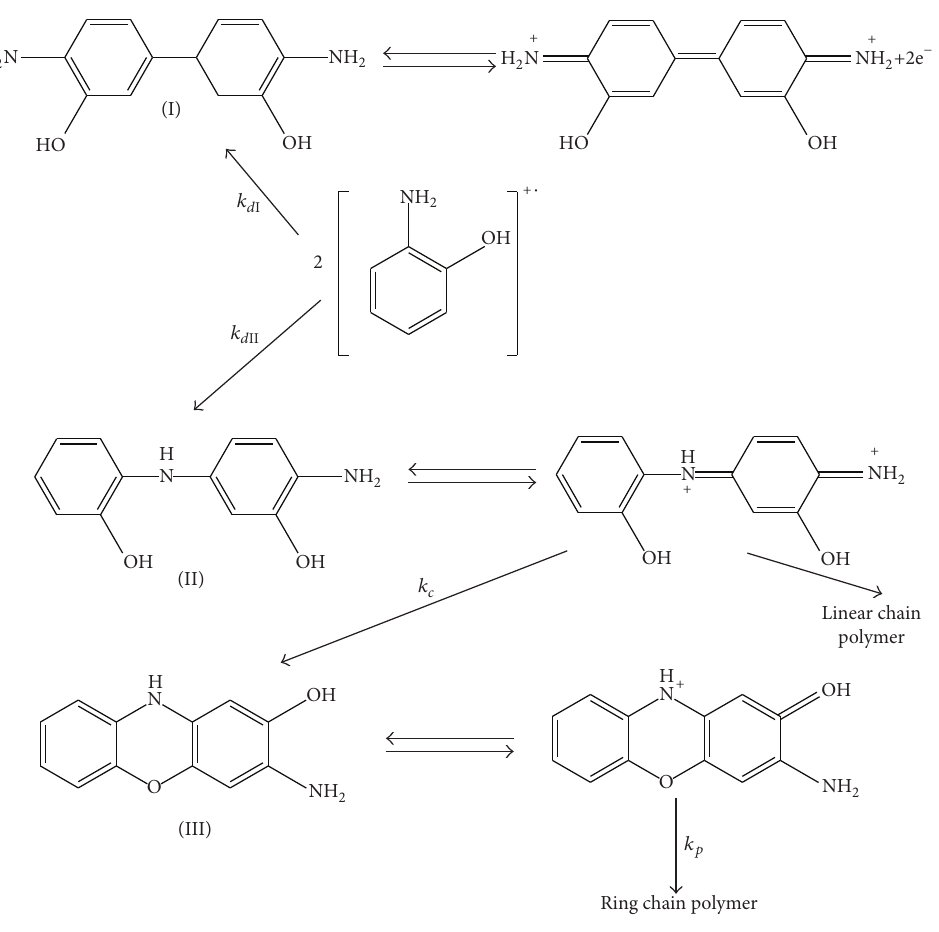
F 3: Mechanism of electrochemical oxidation of o -AP [1].